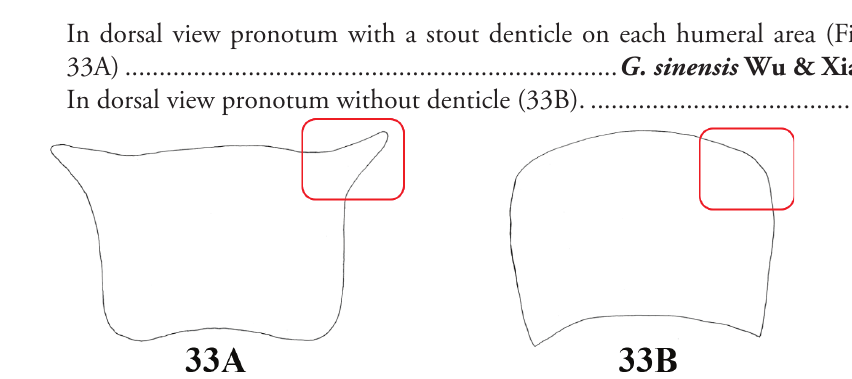
Figure 33. A G. sinensis worker (Cited from Zhou, 2001) B Gnamptogenys sp.